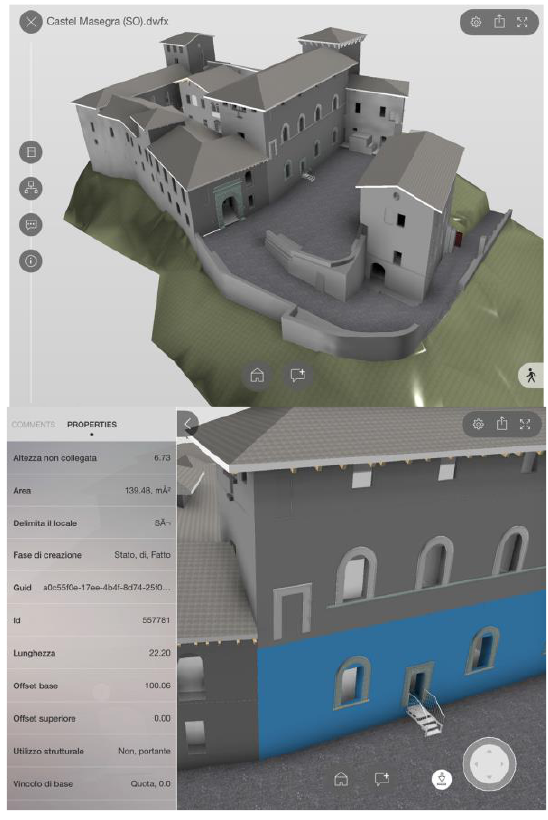
Fig. 7. The BIM of Castel Masegra inspected with A360 on a tablet. The software preserves object information.